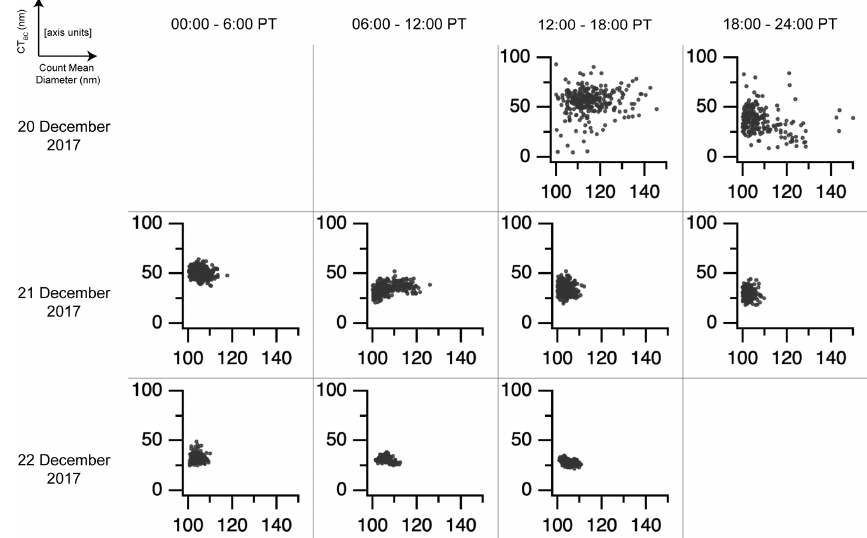
Figure 14. Matrix of scatterplots showing the time evolution of CT BC (nm) and the rBC count mean diameter (nm) for the second campaign (December 2017). Axes labels are shown in the upper left. A scatterplot is shown for each 6h time interval of the day, starting at 00:00PT, and for each day of the campaign. The columns of the matrix denote the time interval of the day, and the rows of the matrix denote the days of the campaign. Each point within a plot represents a 1min mean value for both CT BC and the count mean diameter.